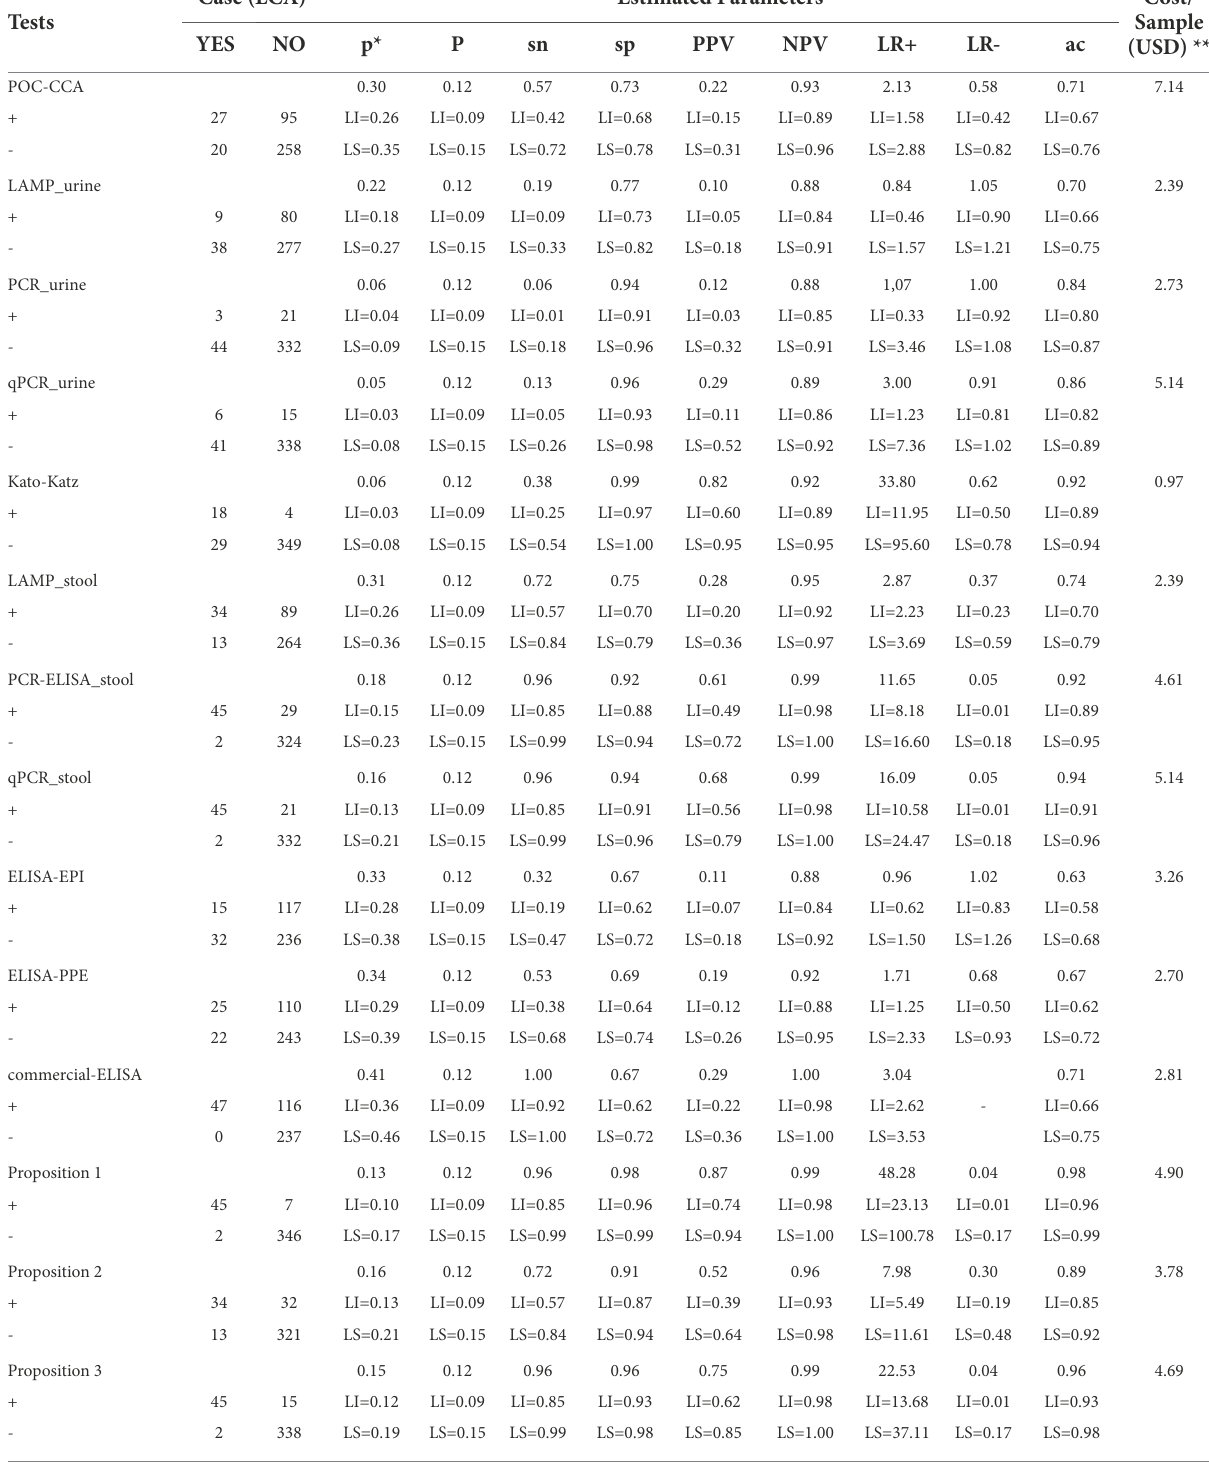
TABLE 3 Estimated parameters of the 11 individual diagnostic tests evaluated, and the three 2-step diagnostic approaches proposed for the active search of infected people in moderate and low endemicity areas, in the current